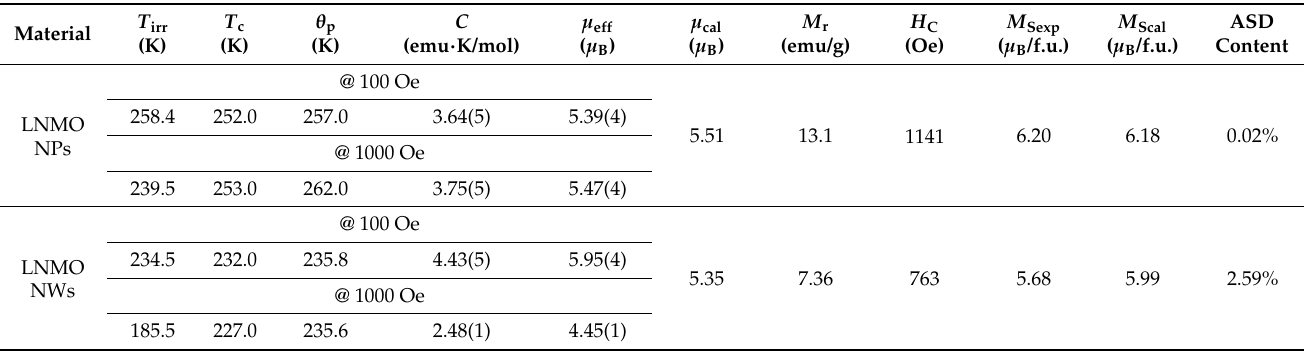
Table 2. Magnetic data of the as-synthesized LNMO NPs and NRs measured at 5 K and their Curie–Weiss fitting